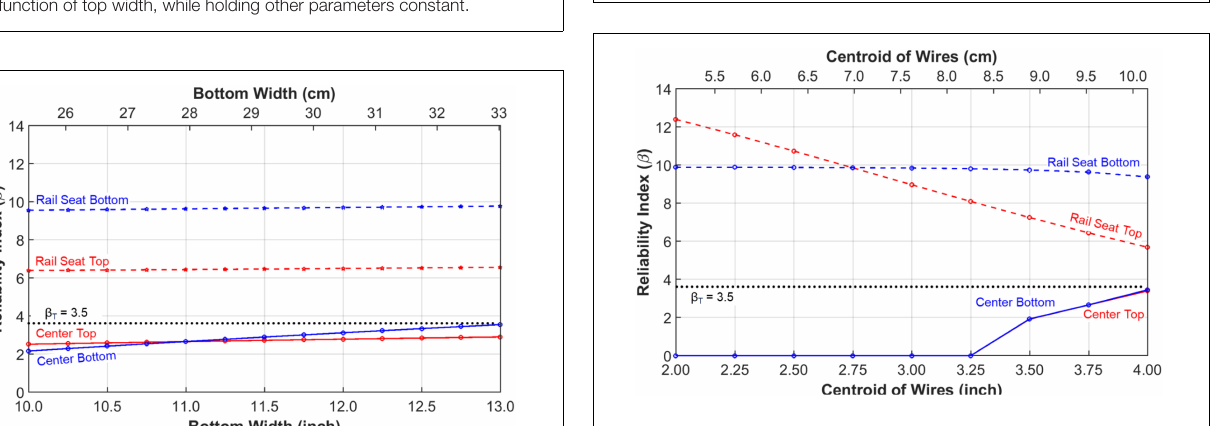
FIGURE 11 | HAL freight center bending moment structural reliability indices ( β ) as a function of prestressing centroid, while holding other parameters